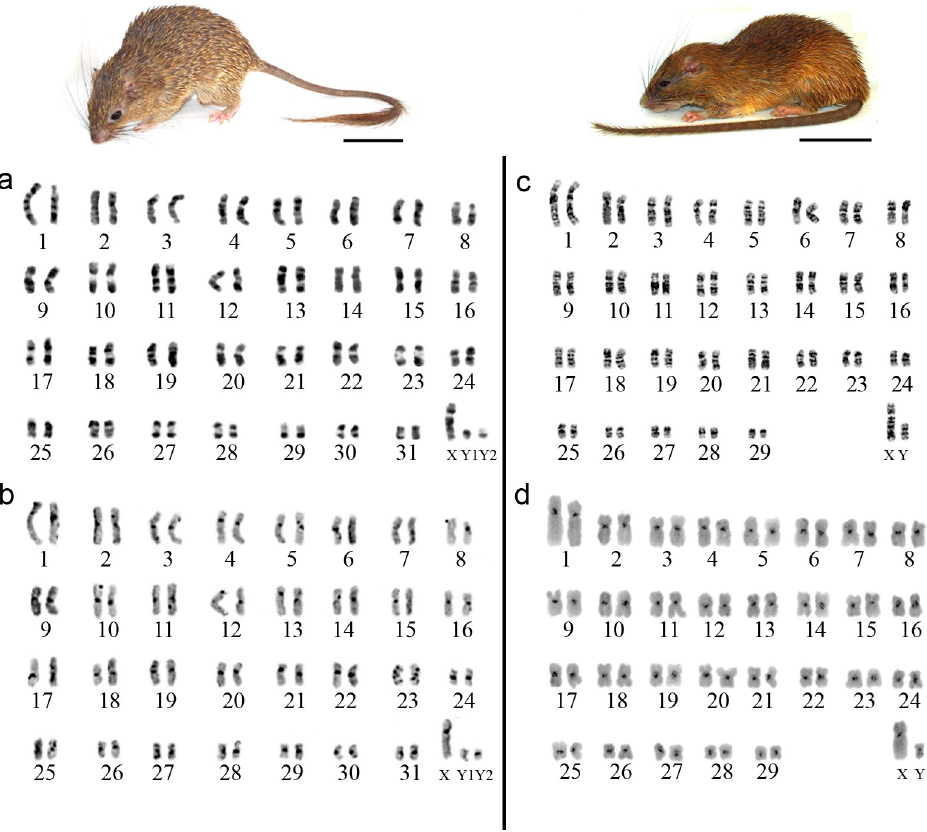
Fig 2. G-banding (a, c) and C-banding (b, d) patterns for the Lonchothrix emiliae (a, b; 2n = 64 ♀ , 65 ♂ /FN = 124) and Mesomys stimulax (c, d; 2n = 60/FN = 116) karyotypes . The images of the respective species analyzed are shown above the karyotypes: L . emiliae (left) and M . stimulax (right). Scale bar: 10 cm. https://doi.org/10.1371/journal.pone.0215239.g002 for the M . hispidus + M . stimulax group, and the P . simonsi + P . cuvieri group had the greatest intrageneric distance (18%). The intraspecific medium nucleotide divergence for each species was < 3.5%, except for M . stimulax (7.1%) (Table 2).